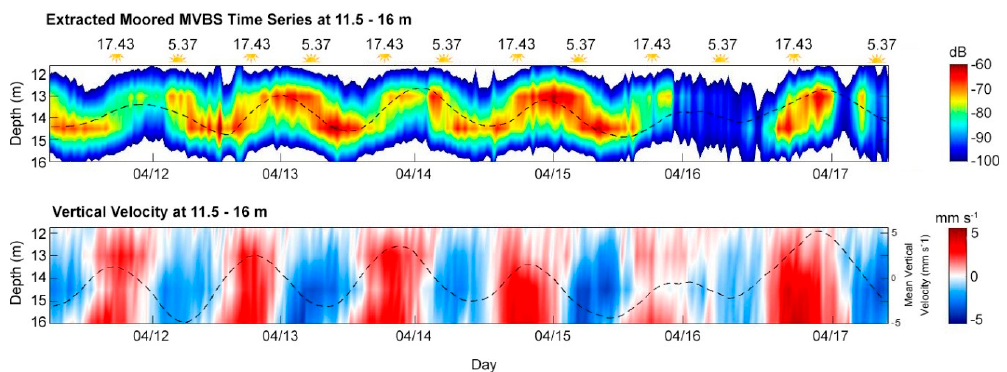
Figure 10. The dashed line shows the center of the sound scattering layer on the echogram and the vertical velocity average at the vertical velocity profile at depths 11.5 - 16 m.